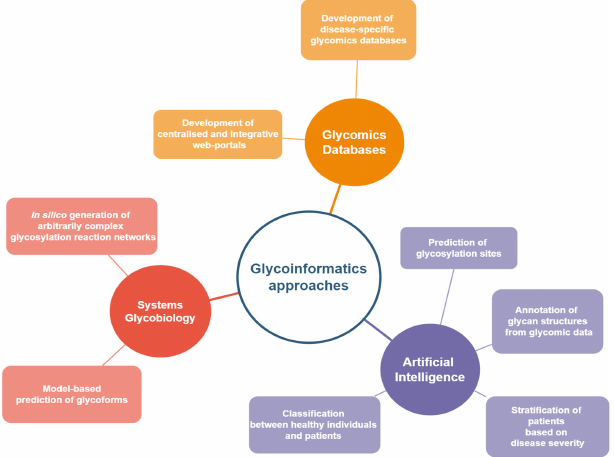
Figure 2. Current trends and developments in glycoinformatics within biomarker discovery.